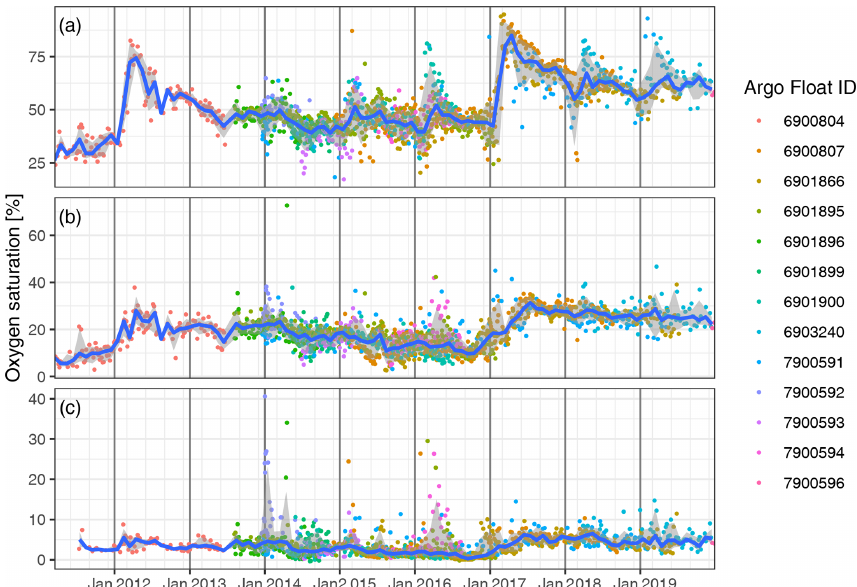
Figure 2. Oxygen saturation levels derived from individual BGC-Argo profiles at σ values of (a) 14.5, (b) 15.0 and (c) 15.5kgm − 3 . Colored points correspond to different Argo floats. The blue line represents monthly medians, while the shaded area covers monthly interquartile